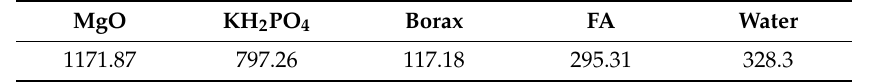
Table 1. Mix proportion of magnesium phosphate cement (MPC) (kg / m 3 ).